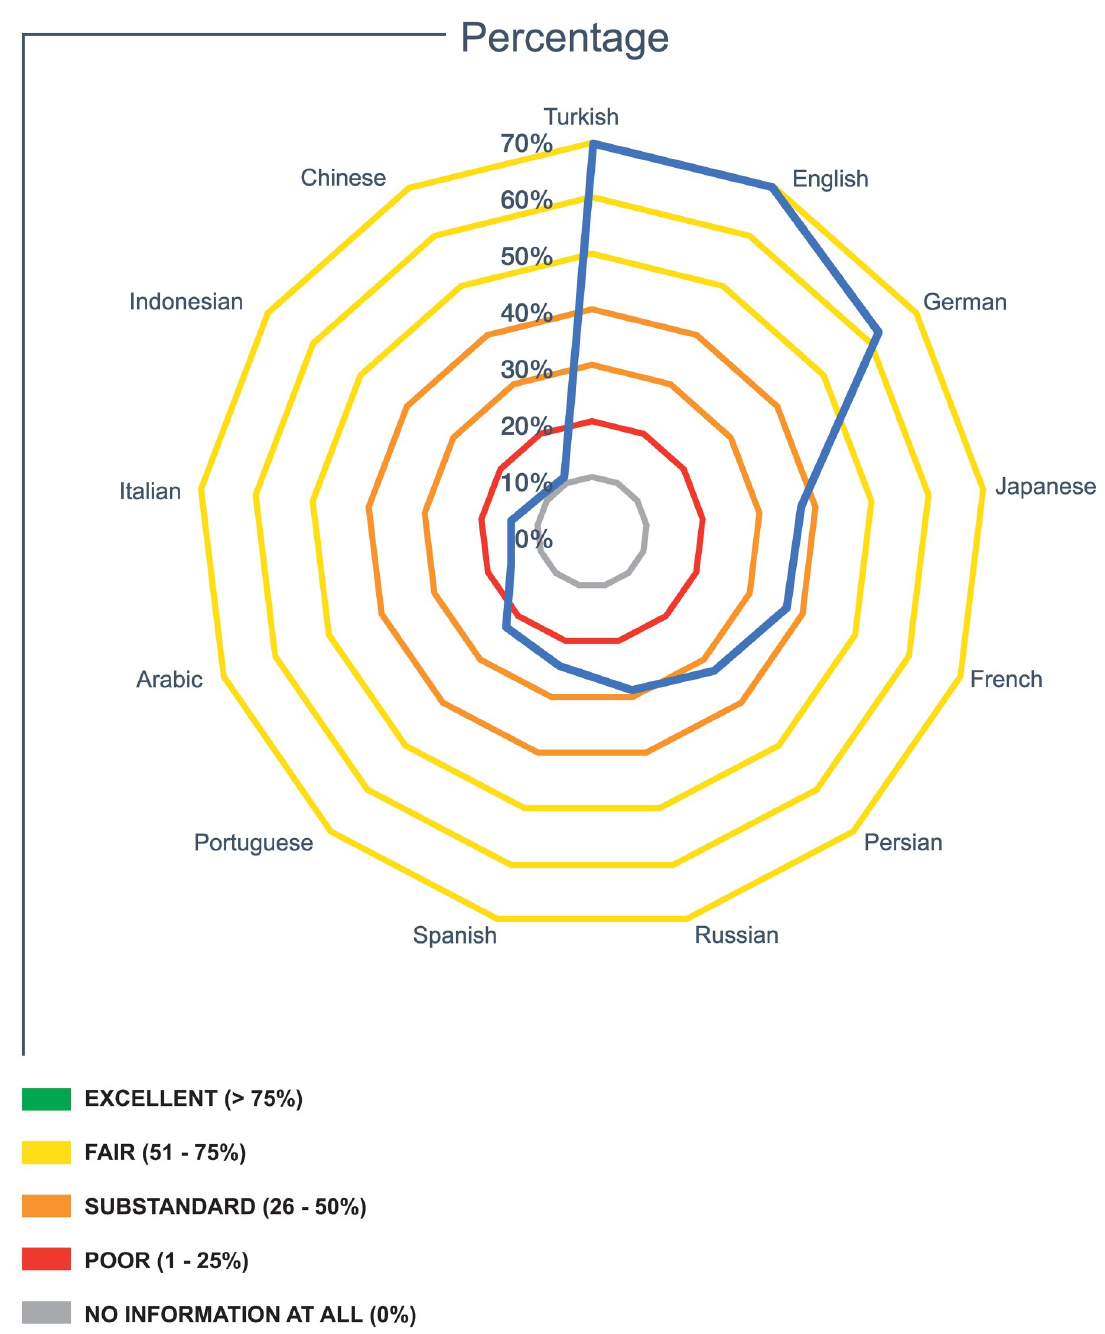
Fig 1. Average percentage per